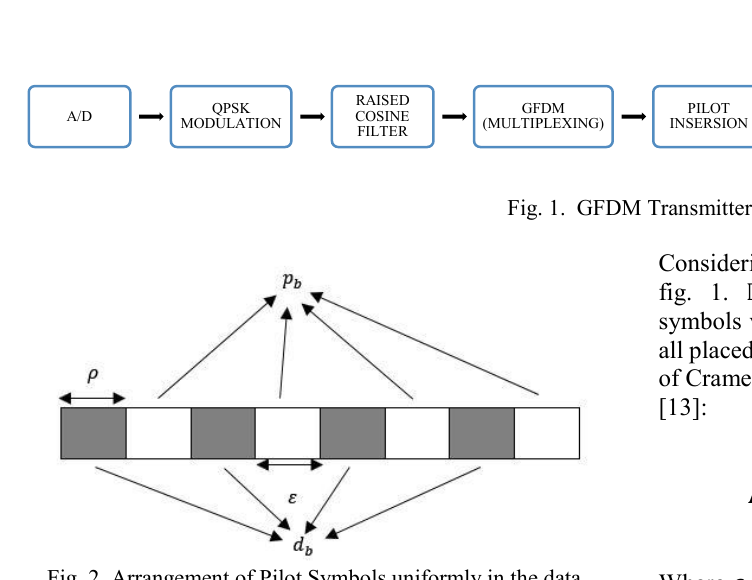
Fig. 2. Arrangement of Pilot Symbols uniformly in the data packet (Method I)